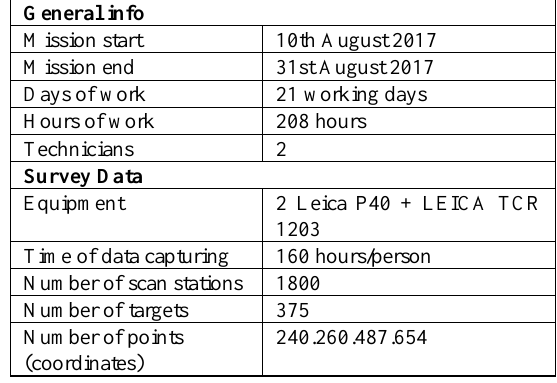
Table 1. Survey data and technical equipment: 3D integrated survey of Museu do Ipiranga –